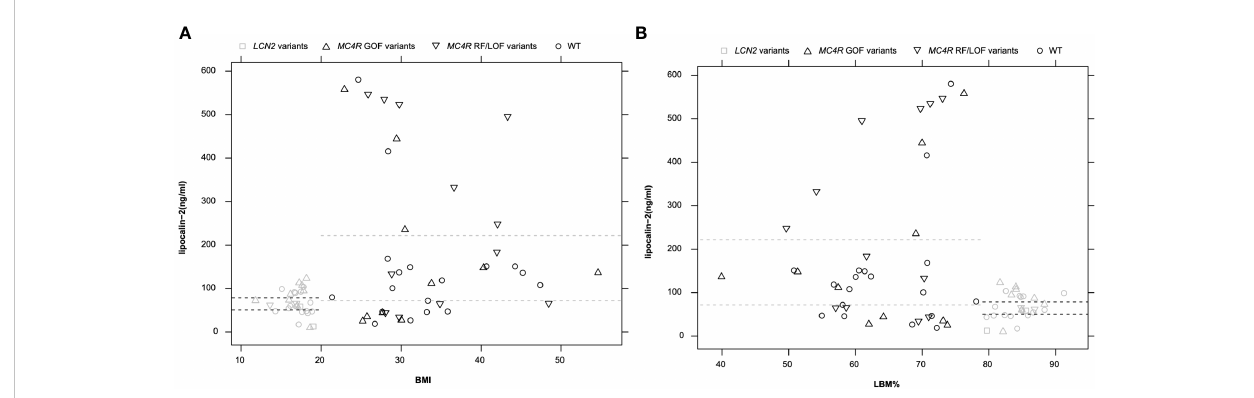
FIGURE 3 Circulating lipocalin-2 level in 68 analyzed individuals including LCN2 -variant carriers (n = 2), MC4R -variant carriers (n = 33), and individuals without variant in these two genes (n = 33). (A) : The pattern of lipocalin-2 levels of all samples was shown along with BMI. (B) : LBM% as a scaled parameter for lipocalin-2 levels (one sample, p.Val103Ile_k, was excluded from this fi gure due to missing LBM% value). Dashed lines indicate the 95% CI of lipocalin-2 in serum in groups of individuals with leanness or obesity. Black symbols indicate obese individuals and grey symbols indicate individuals with